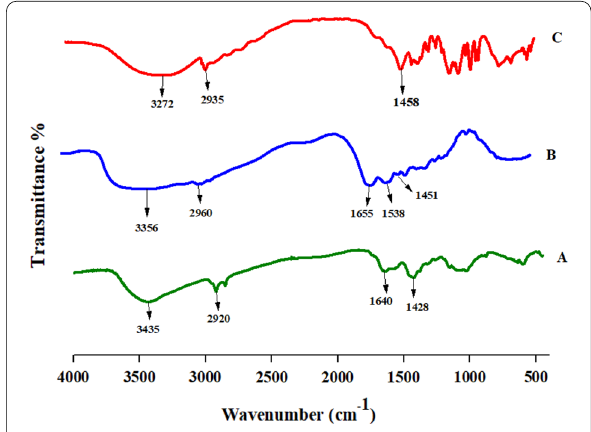
Fig. 8 FTIR spectra showing characteristic peaks of chitosan ( a ), BSA protein ( b ) and BSA nanoparticle ( c